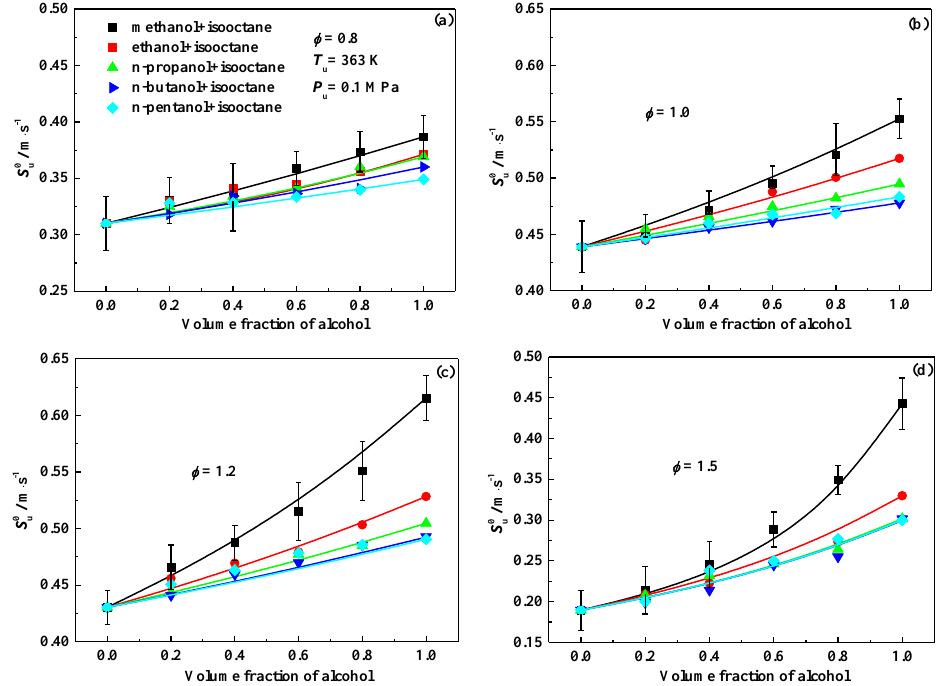
Figure 3. Laminar flame speeds of the alcohol-isooctane blends vs. volume fraction of alcohol at 363 K, 0.1 MPa, and different equivalence ratios: ( a ) ϕ = 0.8; ( b ) ϕ = 1.0; ( c ) ϕ = 1.2; and ( d ) ϕ = 1.5. Lines are calculated using Equation (8) in Section 3.4.